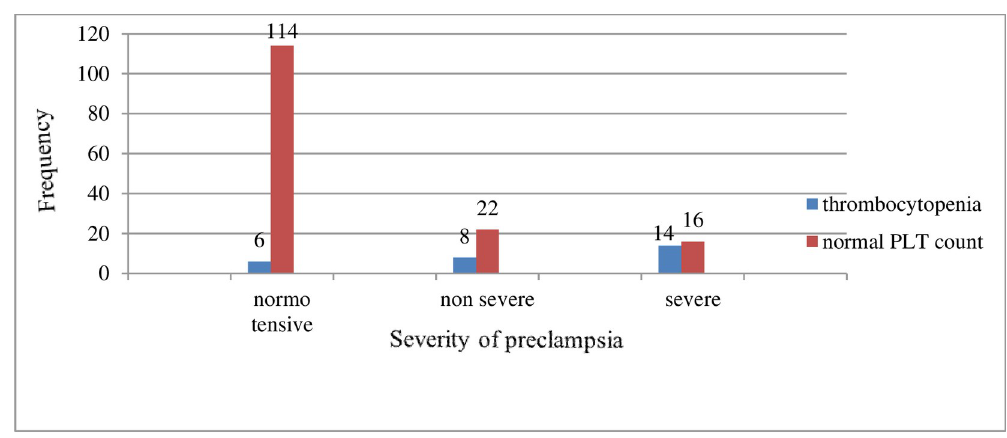
Fig 1. Frequency of thrombocytopenia among study participants in NEMMCSH from January 1 to April 3, 2019.